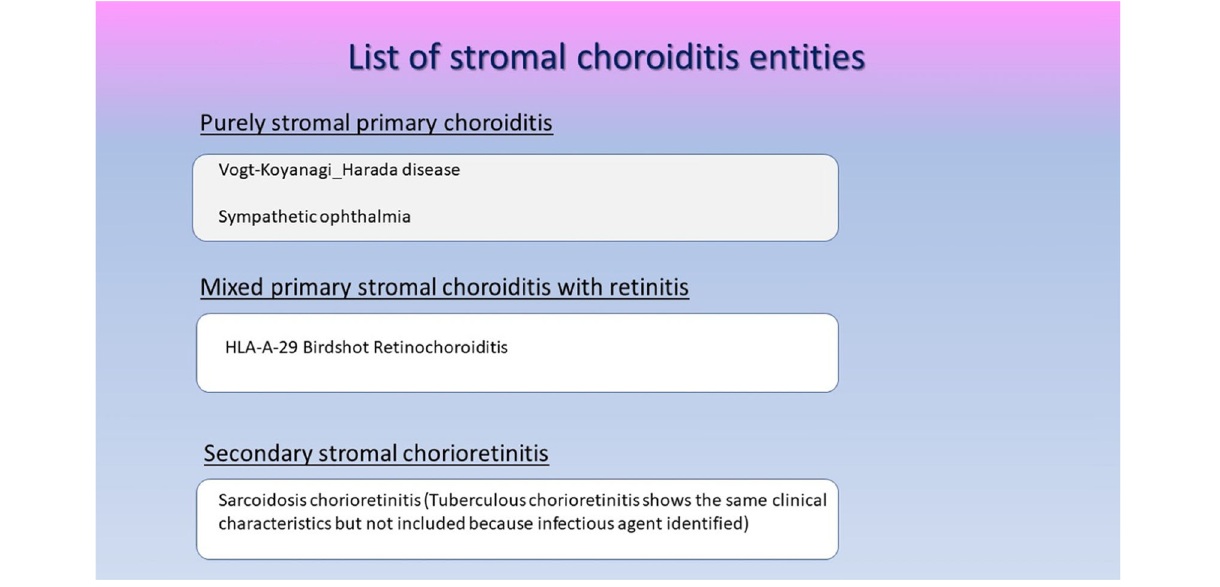
Table 3 List of stromal choroiditis